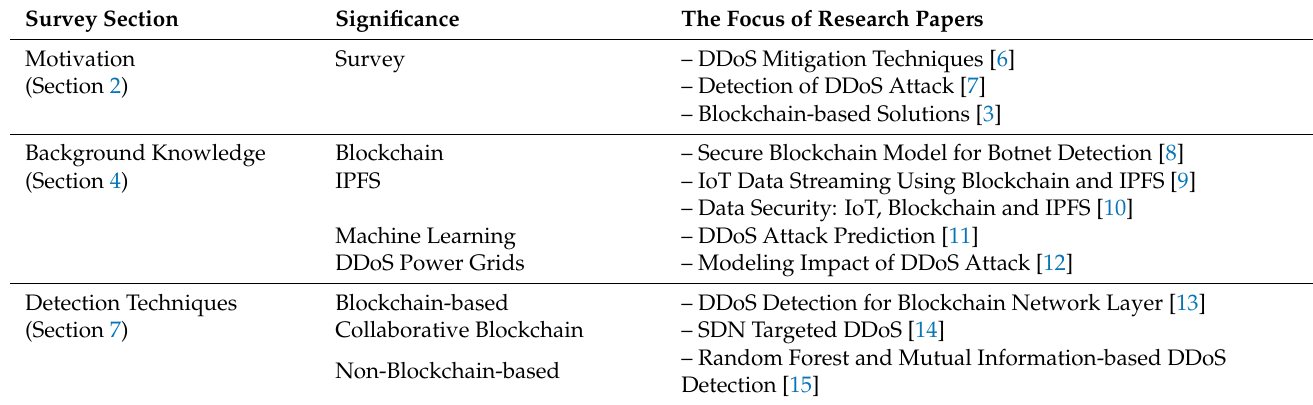
Table 1. Contribution table: latest research pertaining to relevant